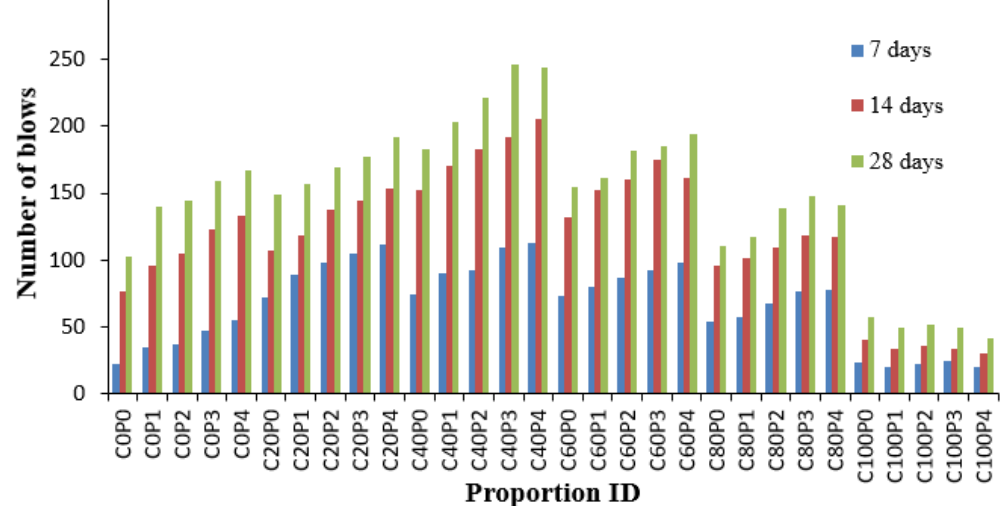
Figure 8. Variation of impact resistance at failure stage.